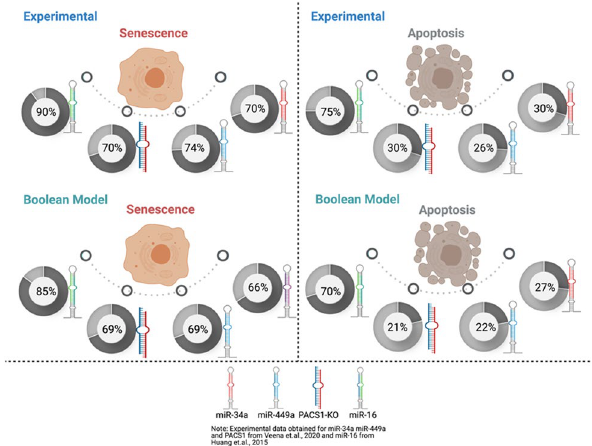
Figure 4. Cross-validation through the experimental studies. Upperside: cell fate decisions such as senescence and apoptosis indicate its corresponding experimental study 2,7 . Whereas, down-side: cell fate decisions such as senescence and apoptosis signify the single node model perturbation. Each circle represents the phenotype percentage that was observed in each experimental study 2,7 . Whereas, the model perturbation for each molecule was obtained through the Monte Carlo simulations (10,000 runs). miR-34a, miR-449a, and miR-16 represent Gain-of-Function (GoF). Whereas, knockdown (KO) represents Loss-of-Function (LoF). For more detail see "Cross-validation through the experimental studies"